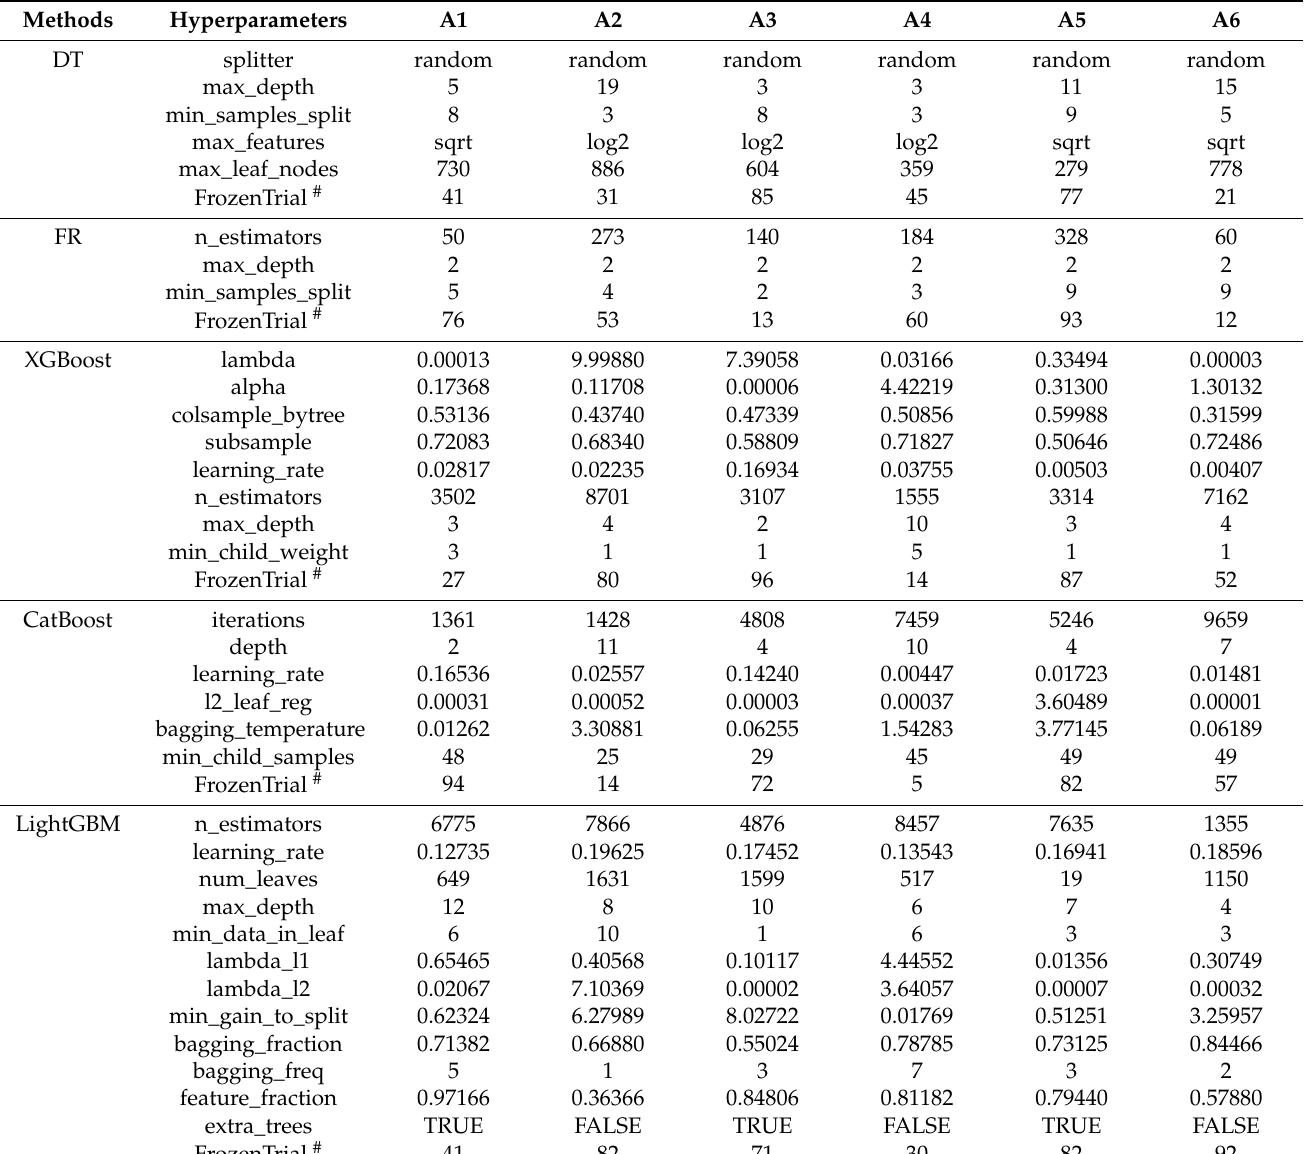
Table 9. The hyperparameters for category A models provided by